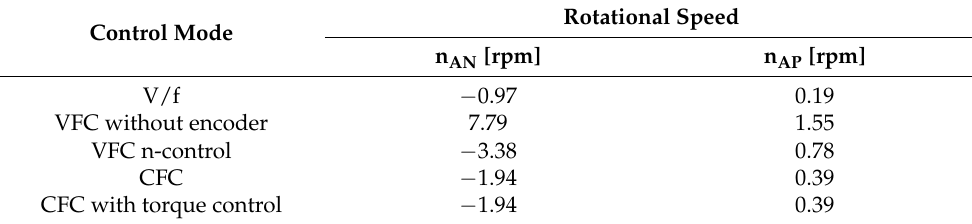
Figure 9. Comparison of the rotational speed (n A ) for various control modes, where VFC is VFC without an encoder. Table 14. Value of the overshoot of the rotational speed in the transient state (with the external load).